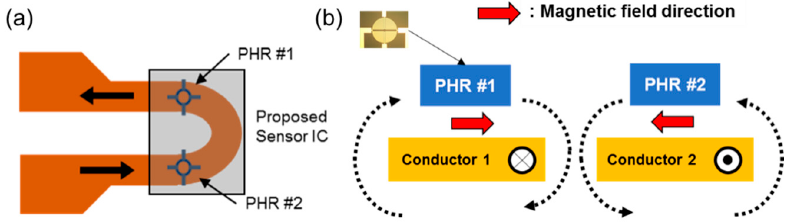
Figure 2. ( a ) The proposed differential structure with two PHR sensors and the directions of the magnetic field and ( b ) the location of the current sensors on a current-flowing conductor.